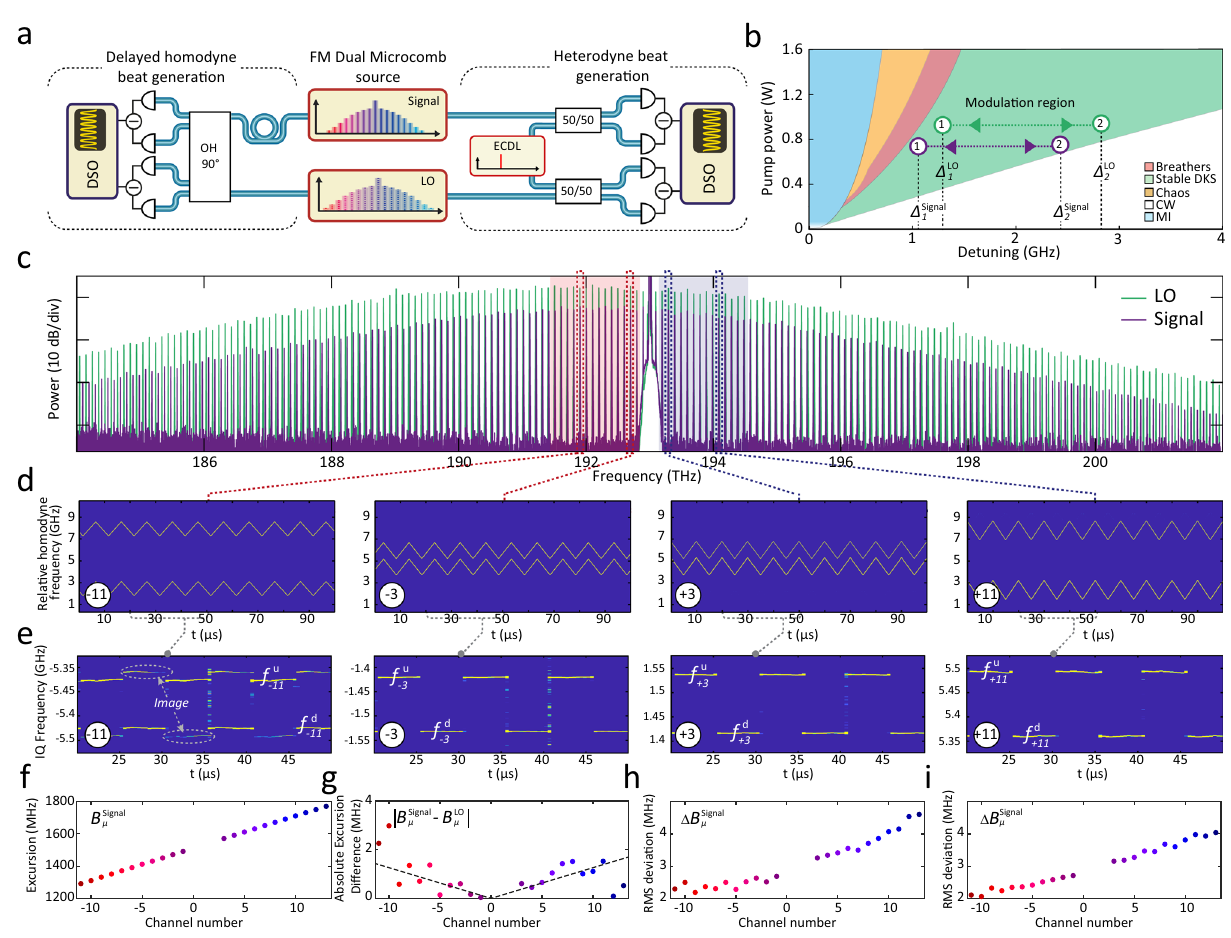
Fig. 2 Coherent detection of multiple frequency modulated laser channels. a Optical setup for heterodyne and delayed homodyne beat note measurement. The signal microcomb is delayed and mixed in a 90 ∘ optical hybrid and superimposed with the local oscillator (LO) microcomb on a pair of balanced photoreceivers for delayed homodyne beat frequency generation. Alternatively, the tuning of individual comb line pairs is characterized by heterodyne mixing with an external cavity diode laser (ECDL). b Soliton microcomb stability chart. Optical resonances are thermally tuned to superimpose the laser-cavity detuning regions of stable soliton generation (green shaded). MI modulation instability, CW continuous-wave. c Optical spectra of signal and LO combs featuring a slight offset in repetition rate. The blue(red) shading highlights positive(negative) channels ( μ = 0 denotes the pump laser) used in LiDAR experiments limited by the available ampli fi er bandwidth and ampli fi ed spontaneous emission noise. d Time-frequency map of heterodyne beat spectroscopy at the ±3 and ±11 channels. ENBW 2.45 MHz. e Time-frequency map of delayed homodyne beat spectroscopy. ENBW 2.45 MHz. Image peaks are related to imperfect phase compensation in IQ detection (cf. Supp. inf). f Channel-dependent frequency excursion bandwidth at the 100-kHz modulation frequency. g Channel-dependent absolute excursion difference of signal and LO combs. h , i Channel-dependent RMS deviation from a perfect triangular frequency chirp for LO and perform proof-of-principle parallel ranging experiments. The setup is depicted in Fig. 3a. The soliton microcombs are ampli fi ed in erbium-doped fi ber ampli fi ers (EDFA). The target comprises three chess fi gures (queen, king and pawn — cf. Supplementary Fig. 9) placed approximately ~1 m in front of the beam-splitter and optical transmission grating. A single-axis galvanometric mirror is used for beam scanning in the vertical direction. Figure 3c depicts the optical spectrum of the signal comb interrogating the target. The Fourier transform of the complex signal I + iQ , photodetected on the coherent receiver during 10 μ s, represents a two-sided spectrum containing information about all 28 channels (cf. Fig. 3b). Blue and red shadings highlight positive μ > 0 and negative μ < 0 frequency comb teeth with respect to the pump laser frequency. Two different projections of the 3D-imaging results for a scan of 136 vertical angles across the set of chess fi gures are depicted in Fig. 3d,e. A line of 28 pixels is recorded during a single 10 μ s triangular laser chirp, which equates to a true, i.e., bona fi de 2.8 MPix/s coherent distance sampling rate at the sampling oscilloscope. We emphasize that this